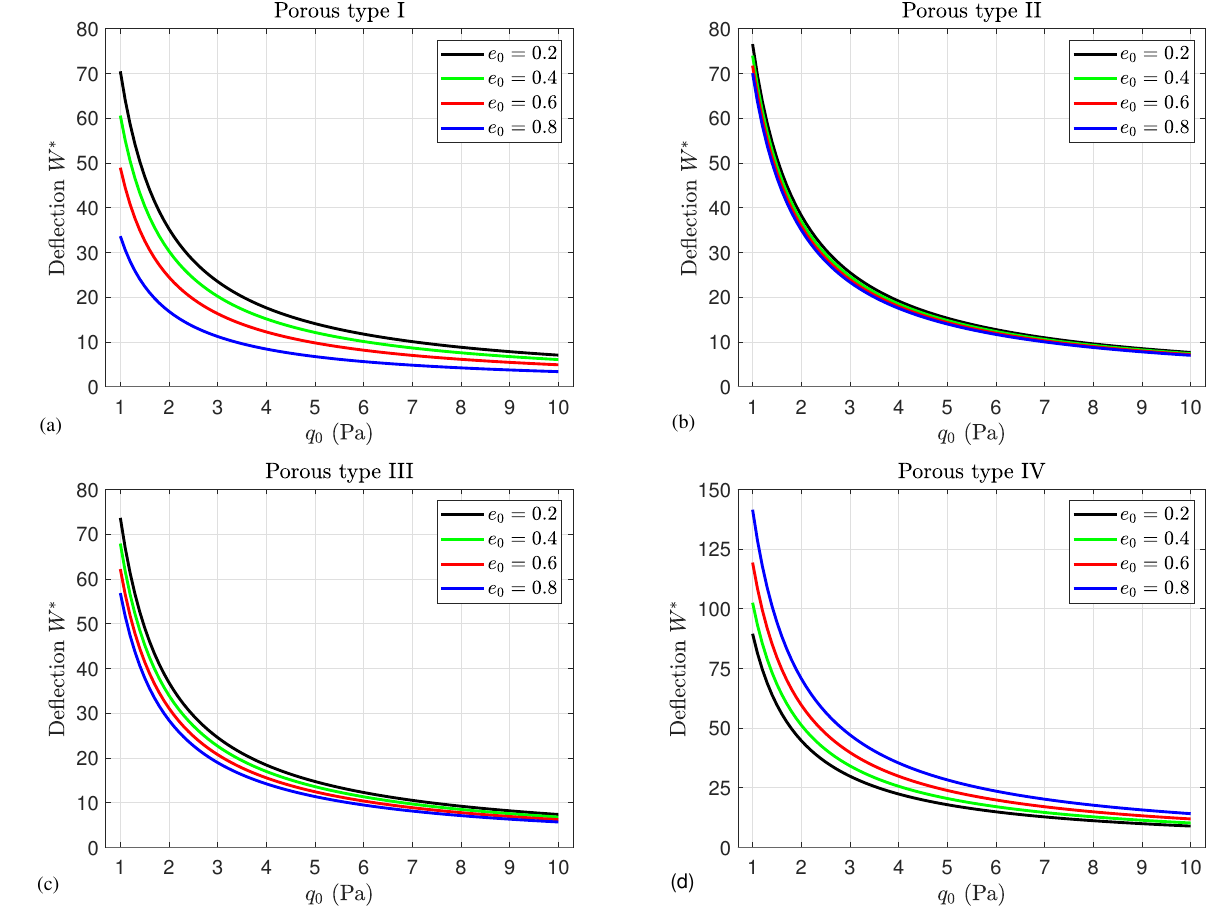
Figure 4. Influence of the porosity factor e 0 on the central deflection W ∗ of GPLs Pattern A of FG porous nanocomposite piezoelectric square plates for different porosity distribution types: ( a ) Type I, ( b ) Type II, ( c ) Type III and ( d ) Type